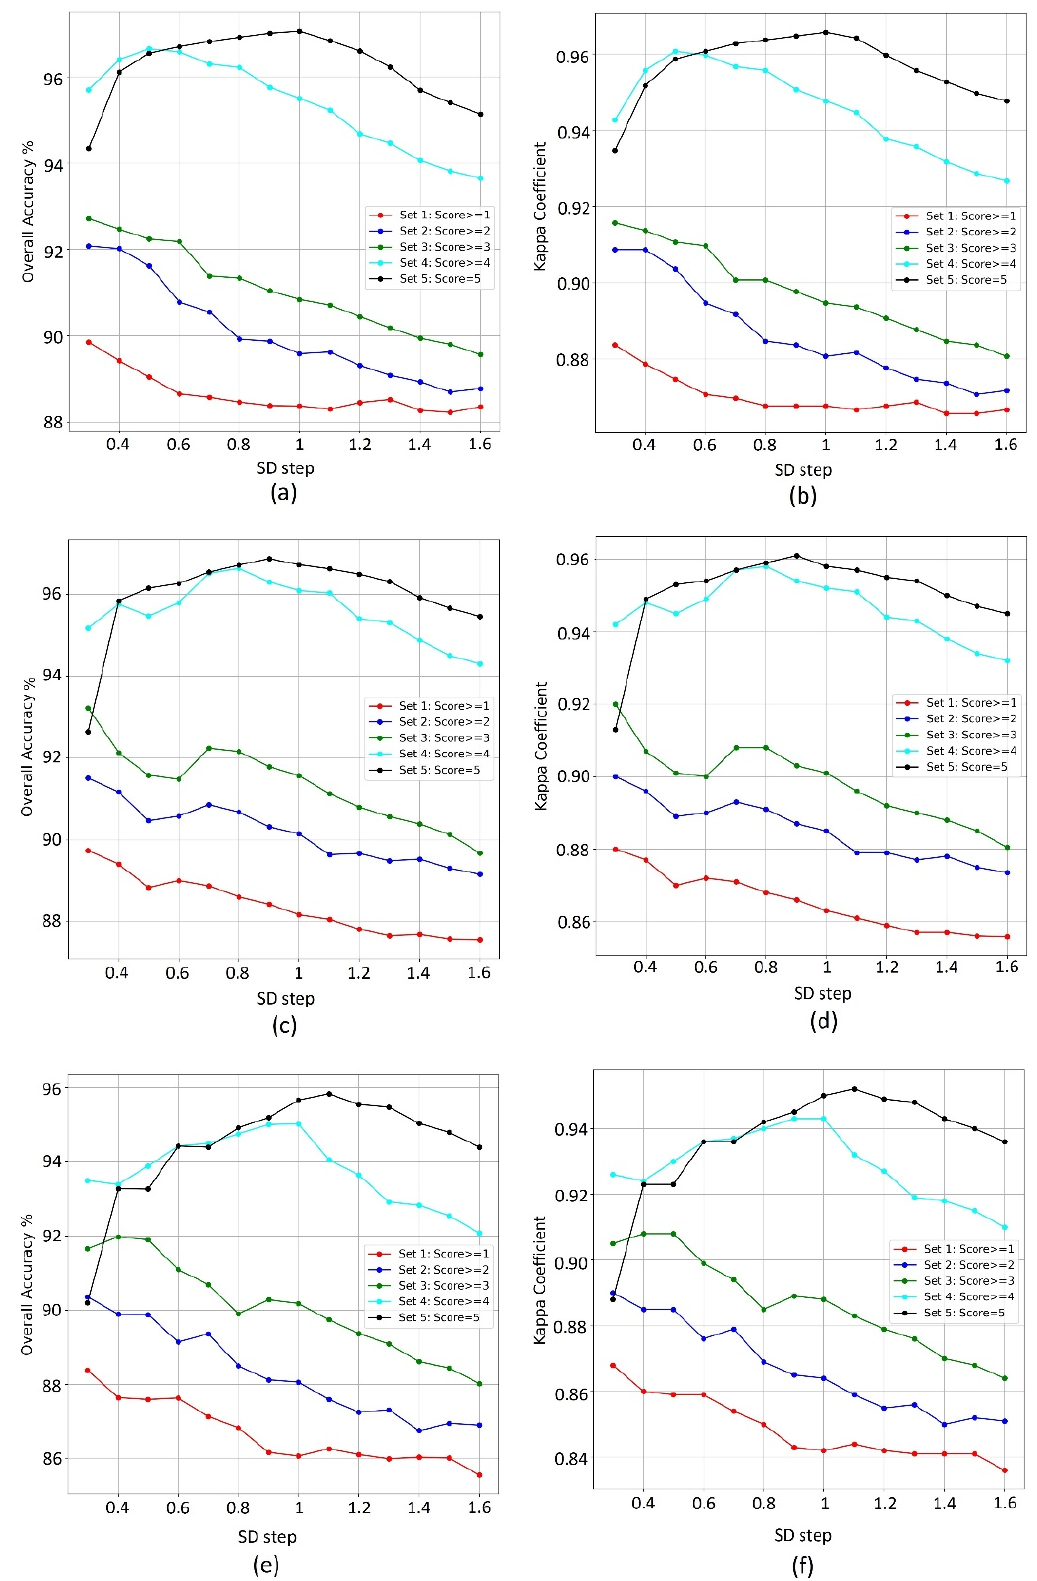
Figure 7. The results of the proposed method for selecting unchanged training samples by determining the optimum threshold value based on the highest OA and KC in the classification of the test samples. ( a – f ) The results for the target years of 2021, 2019, and 2018, respectively.